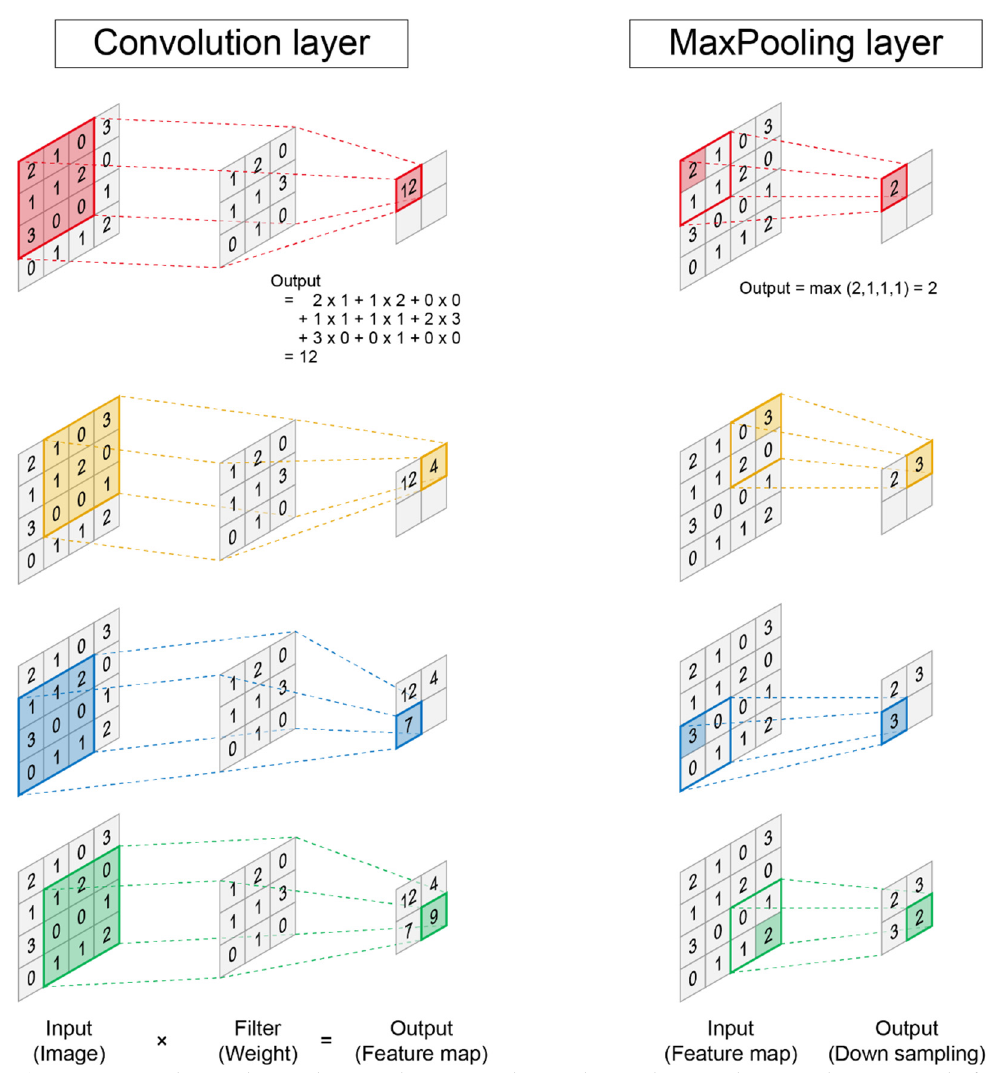
Figure 3. Convolutional neural network.: A convolutional neural network is mainly composed of two types of layers. In the convolution layer, the value obtained by multiplying the corresponding input and filter values is summed in all frames, and it becomes the value of the feature map in the next layer ( left ). In the pooling layers, the maximum or average value is the output. The right panel shows the maximum pooling layer that outputs the maximum value in the frame ( right